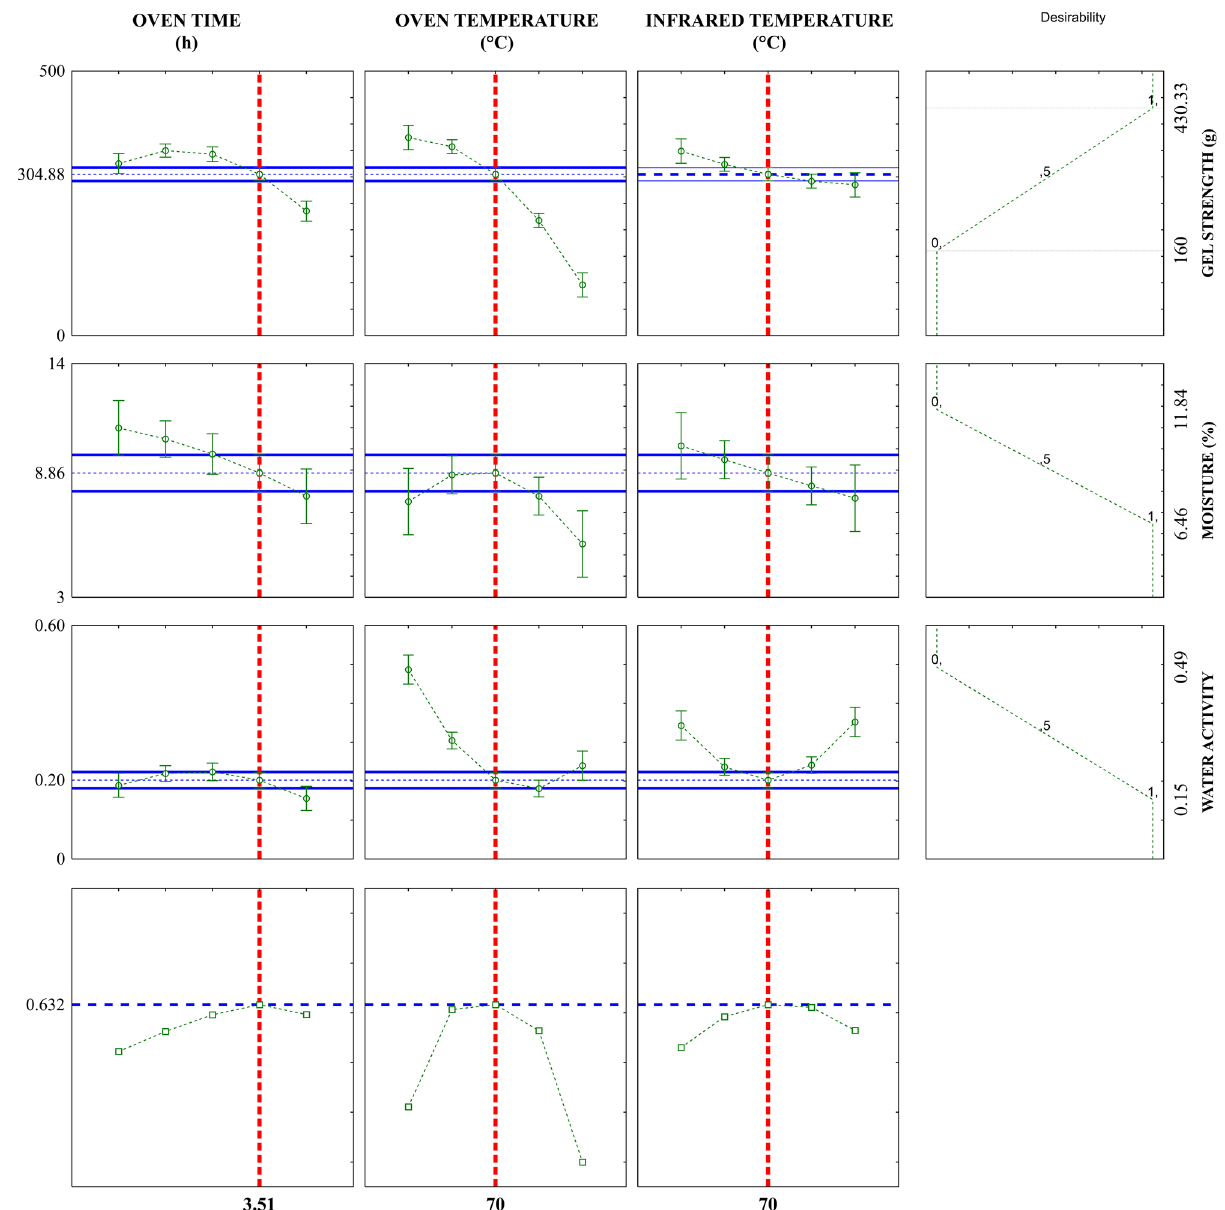
Figure 4. Desirability profiles for infrared temperature and oven temperature and time for the combined drying